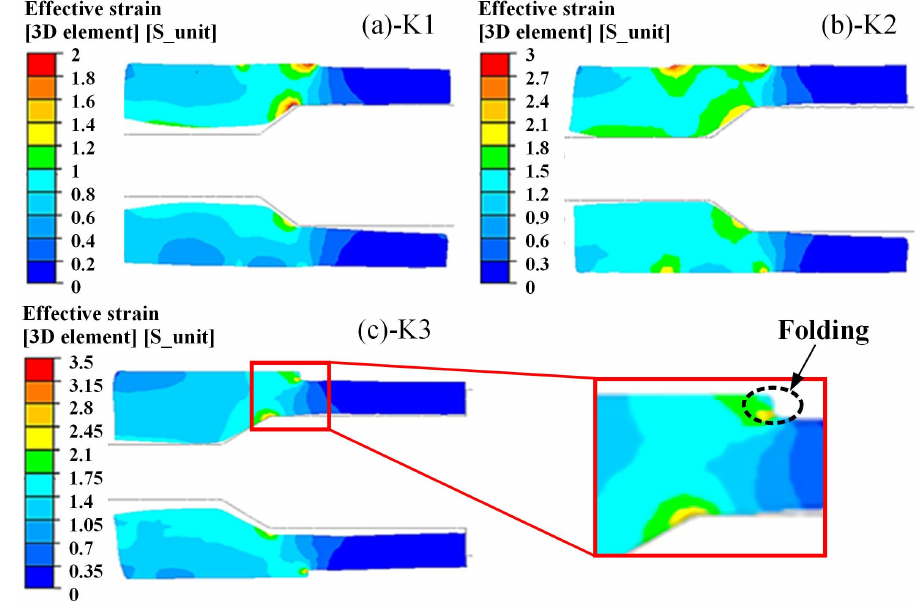
Figure 14. Results of different preforming design schemes: ( a ) K1; ( b ) K2; ( c ) K3.